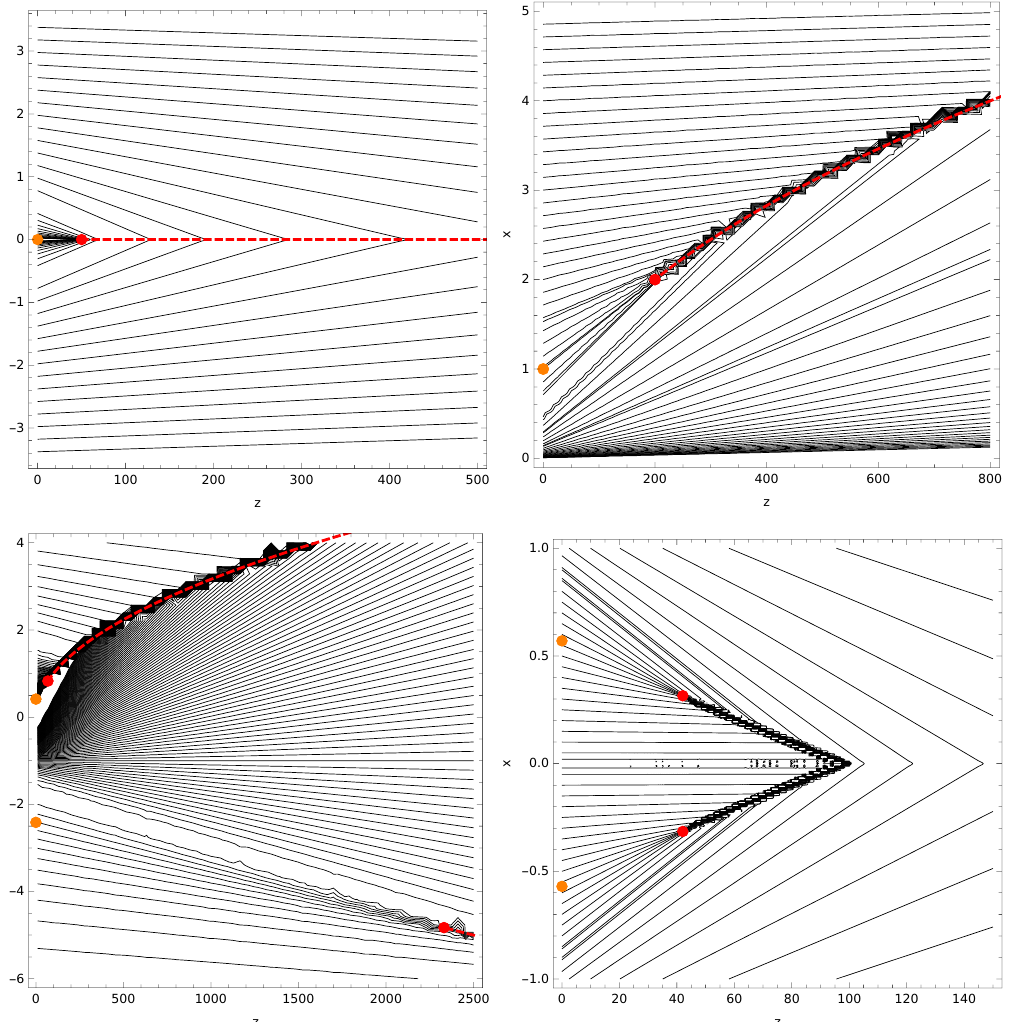
Figure 3 . Contour plots for the functions @ z t + ( z; x ) respectively @ x t + ( z; x ) (up to numerical errors, the contours for both expressions are identical) for various boundary conditions t bdy ( x ). Top left : t bdy ( x ) = 0 : 01 . Top right : t bdy ( x ) = (cid:0) 0 : 01 . Bottom left : t bdy ( x ) = 0 : 01 (cid:1) x . Bottom 1+ x 2 1+ x 2 1+ x 2 right : t bdy ( x ) = 0 : 01 . The black lines are projections of the null rays forming the lightfront 1+ x 4